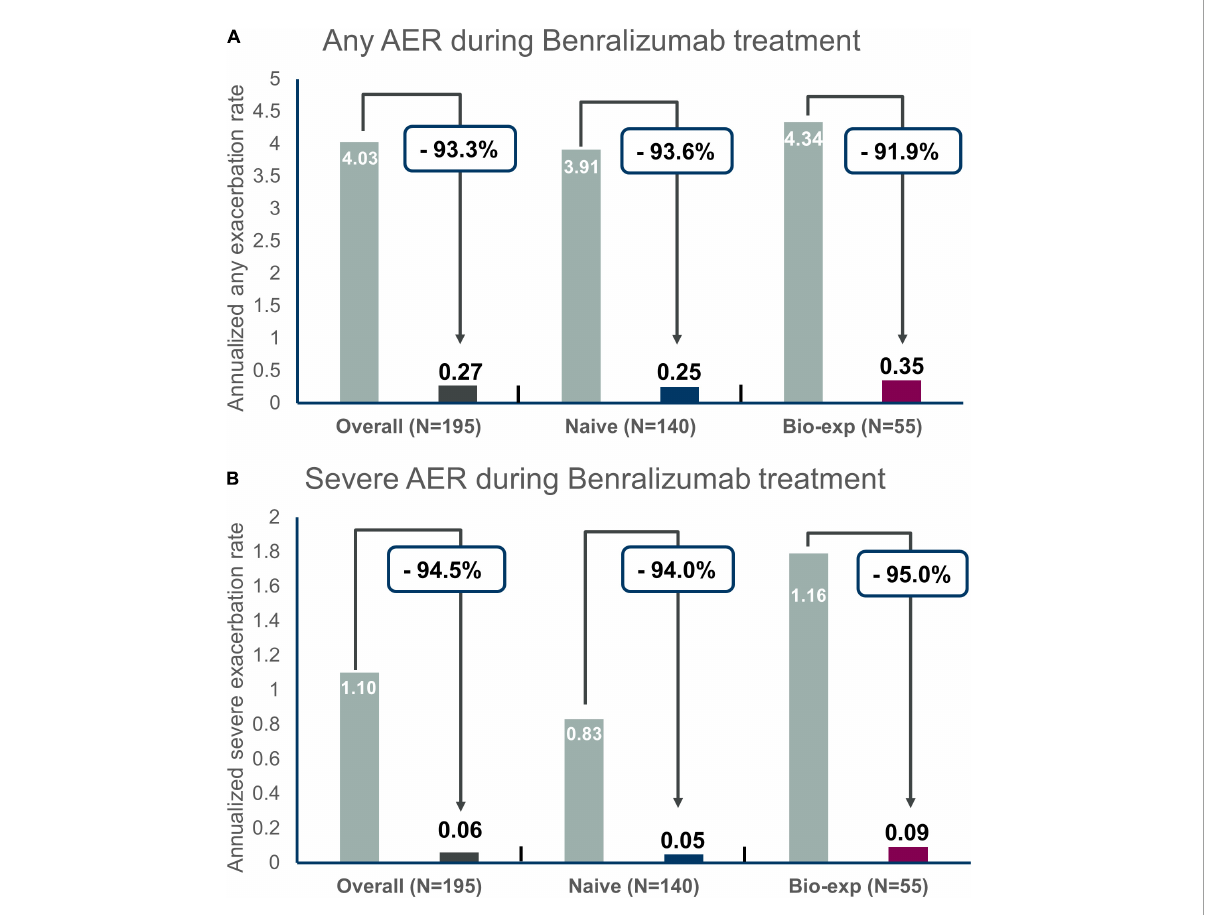
FIGURE1 Annualized exacerbation rates (AER) of any severity (A) and for severe exacerbations (B) during benralizumab treatment in the entire population and in naïve severe eosinophilic asthma patients versus biologic-experienced